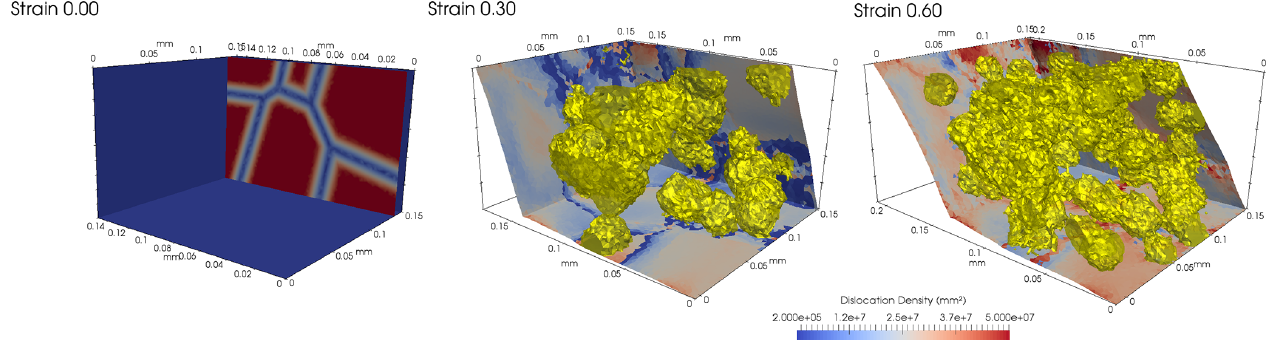
Figure 3. Full field simulation of olivine aggregate deformed in simple shear for the best fitting K g value and for different shear strain. Within the slice (left picture) the maximum of GLS functions is represented, which permits grain boundaries to be visualized. The yellow volumes represent the dynamically recrystallized grains while the color scale represents the total dislocation density within the polycrystal.